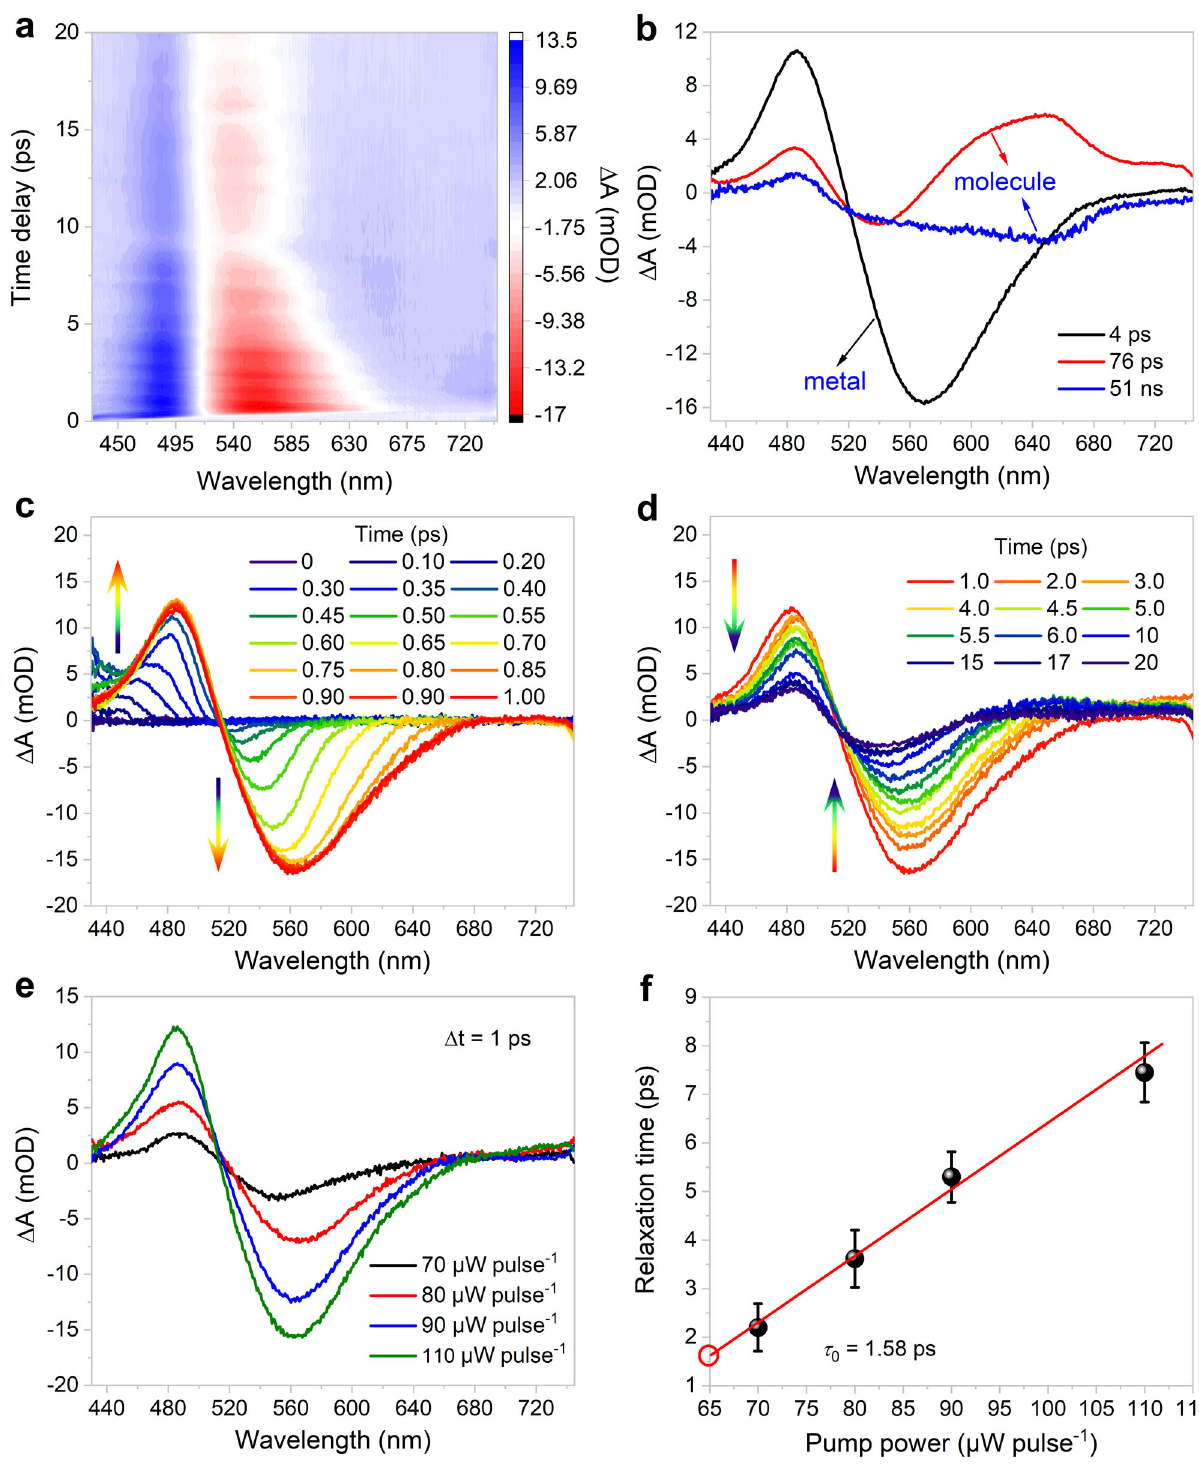
Fig. 6 | Optical properties of Au 138 (SR) 48 . a TA data map pumped at 380nm in toluene at 110 μ W pulse − 1 . b Species-associated spectra (from global fi t analysis). c TA spectra within 1ps. d TA spectra as a function of time delay between 1 and 20ps. e TA spectra measured with different pump energies. f The e – p relaxation